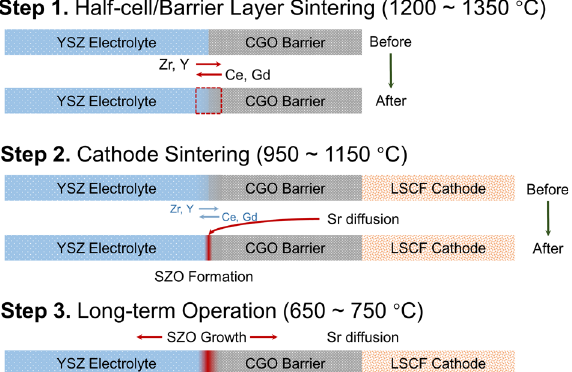
Fig. 1 Schematic diagram of the oxygen electrode – electrolyte interface reactions. The interdiffusion and reaction processes happening in the YSZ – CGO – LSCF region during cell fabrication (Steps 1 and 2) and long-term operation (Step 3) of IT-SOFCs with LSCF